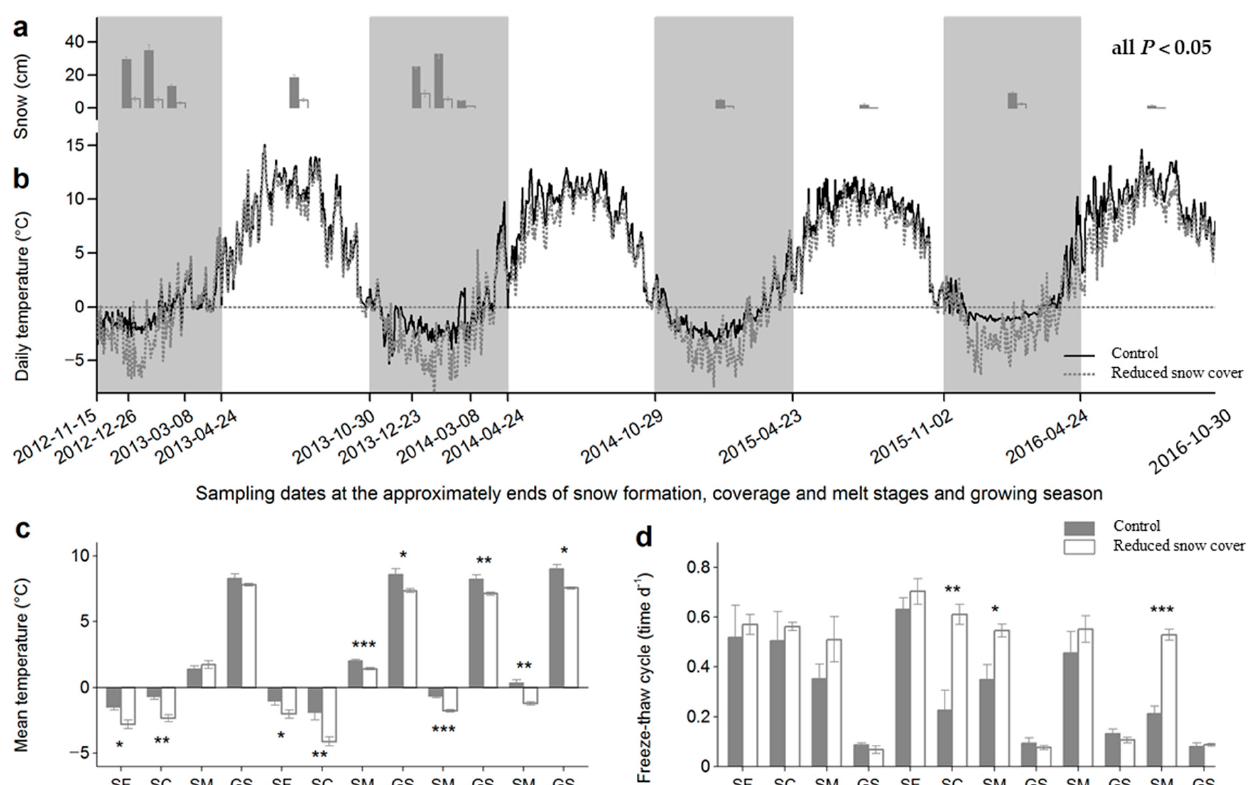
Figure 1. Temperatures and freeze–thaw cycles in the control and reduced snow cover plots. ( a ) Snow depths ( ± SE, n = 18) on each sampling date. Differences between control and reduced snow cover plots were significant ( p < 0.05) on all sampling dates. ( b ) Daily temperatures ( n = 6) at the litter surface during the four years of decomposition. Sampling dates were scheduled at approximately the ends of the snow formation, coverage and melt stages, and the growing season. Winter times, with the snow formation, coverage and melt stages, are shaded. The dashed line is drawn at a daily temperature of zero. ( c ) Mean temperatures ( ± SE, n = 6) at individual stages. Times between two adjacent sampling dates were defined as separate stages to better understand the effect of snow reduction at the snow formation, coverage and melt stages. SF: snow form stage, SC: snow cover stage, SM: snowmelt stage, GS: growing season. ( d ) Freeze–thaw cycles ( ± SE, n = 6) at the individual stages. Values were calculated using the quotients of the total number of freeze–thaw cycles and